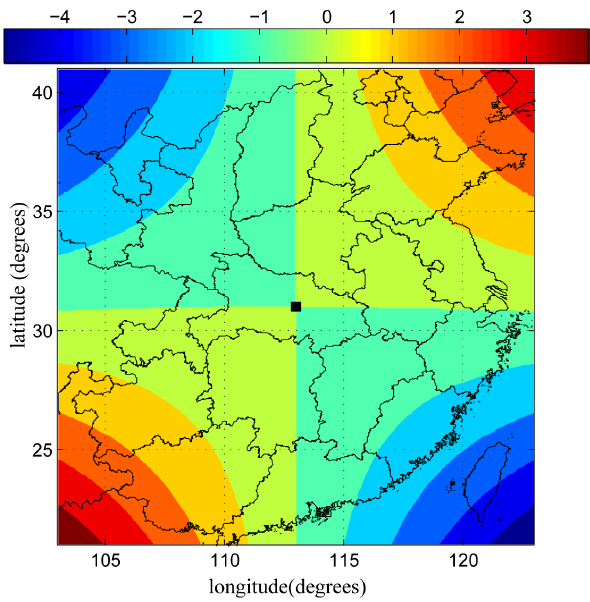
Fig. 6. Same as in Fig. 4 except for the geodesic azimuth difference (in arc sec). At the four corner of the map, the azimuth difference becomes large. Consider that the investigated map covers a large area, the azimuth calculating is accuracy enough for lightning loca-